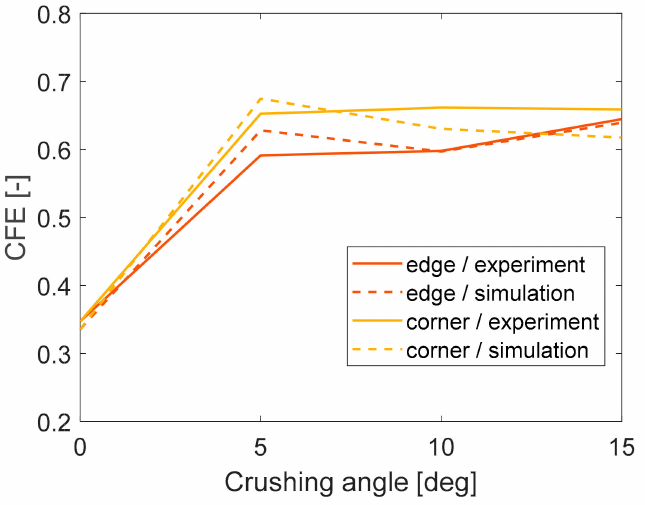
Figure 20. CFE variation with crushing